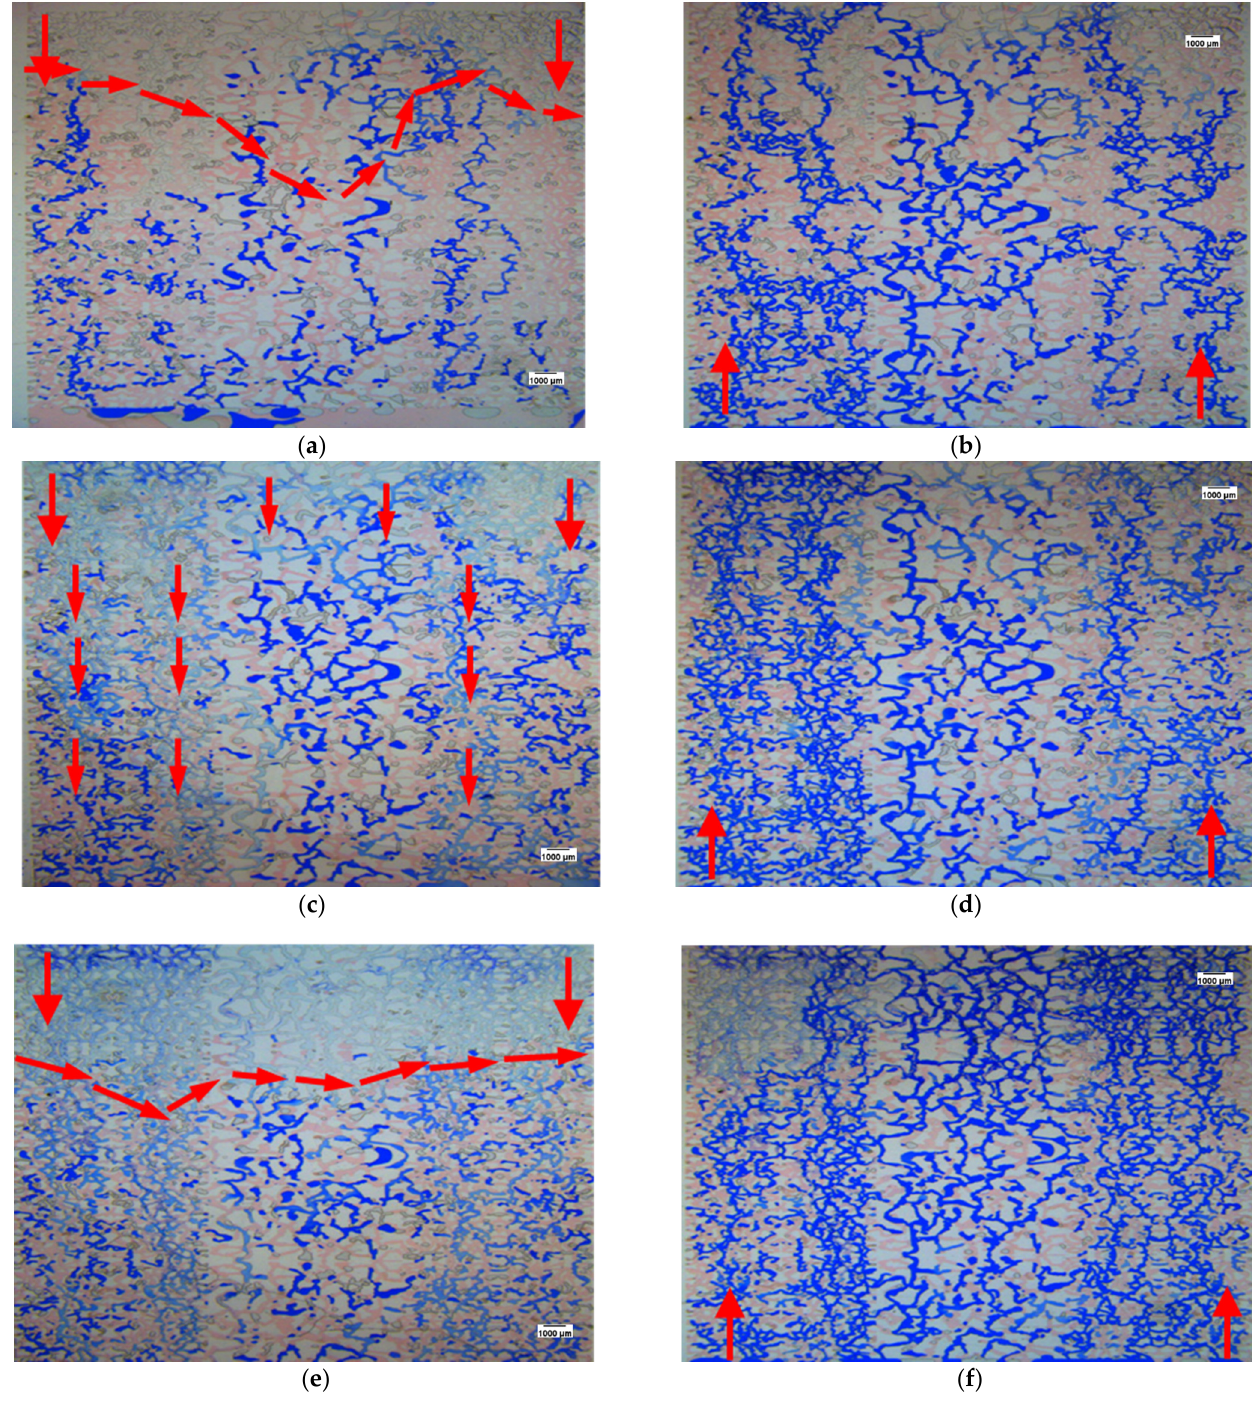
Figure 15. The process diagram of the heterogeneous model gel-emulsifier compound water shutoff process. ( a ) The first gel injection, ( b ) the second water invasion, ( c ) the first emulsifier injection, ( d ) the third water invasion, ( e ) the second gel injection, ( f ) the fourth water invasion.